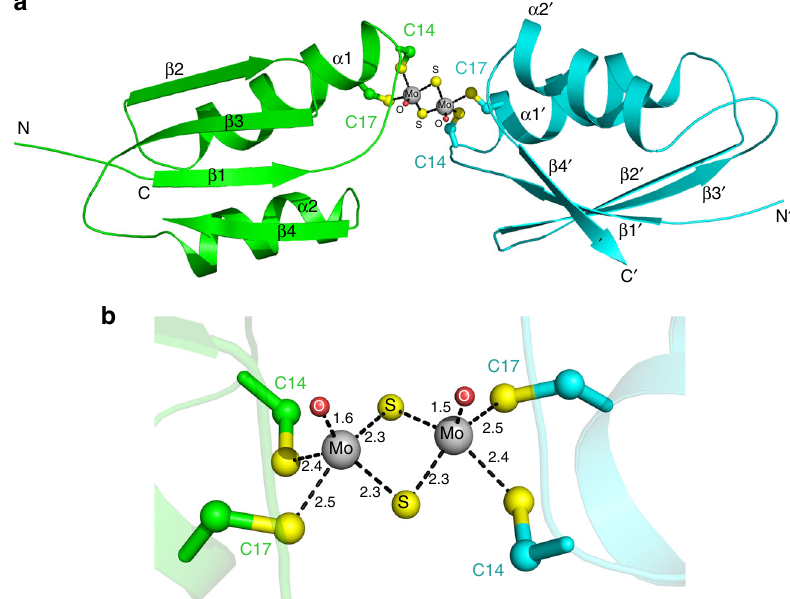
Fig. 1 TM-mediated dimerization of Cu-WLN4. a Overall structure of TM-WLN4 dimer. The two subunits are colored in green and cyan, respectively. The secondary elements are labeled in black. Two Mo atoms are shown as gray spheres. S and O atoms that coordinate to Mo are colored in yellow and red, respectively. Cysteine residues that interact with Mo are shown as sticks. b The detailed coordination of the Mo 2 S 6 O 2 core. The coordination bonds shown as black dash and the bond lengths are